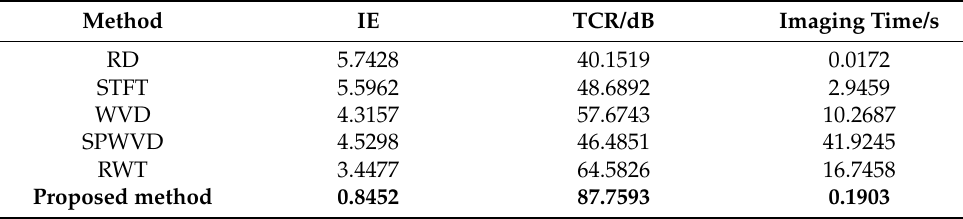
Table 2. The evaluation indicators of different methods under SNR = − 10